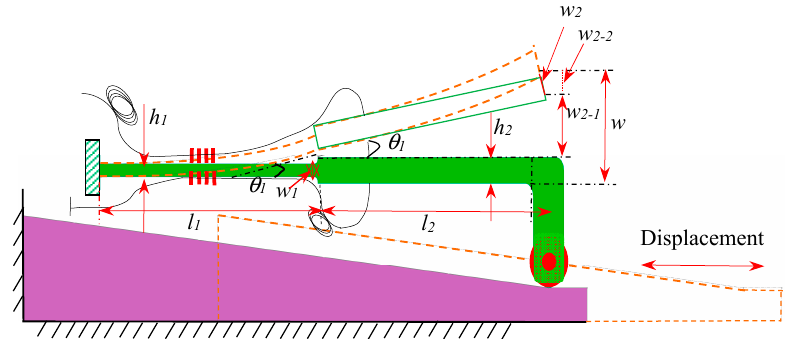
Figure 4. Schematic diagram for the sensing principle of the proposed sensor.